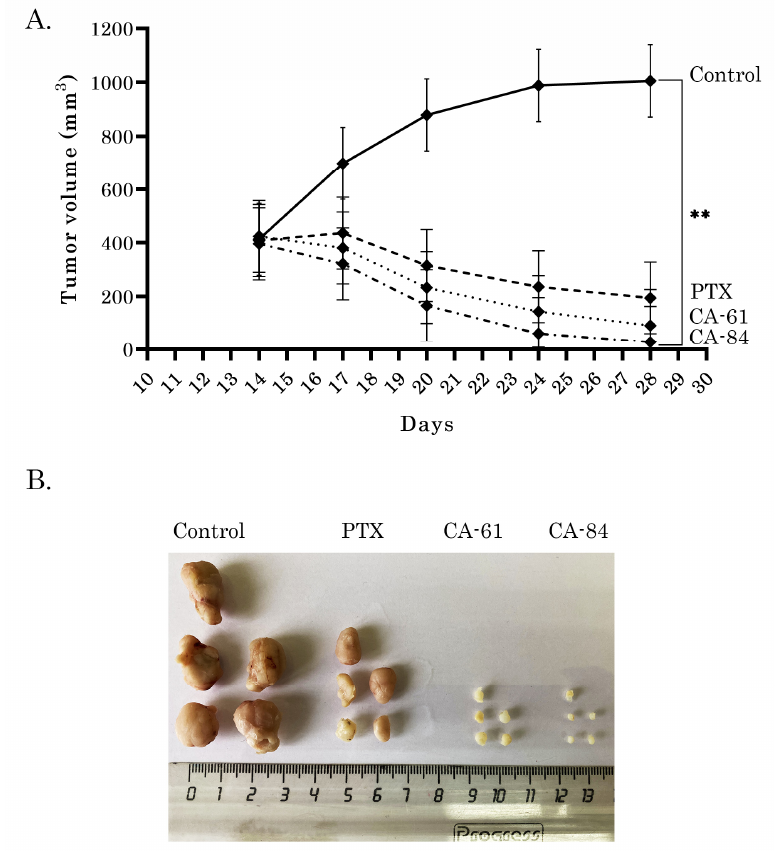
Figure 13. Antitumor effects of CAs and PTX in a nude mice xenograft tumor model. After HCC1806 breast cancer xenografts reached ~400 mm 3 of volume (day 14), nude mice were randomized into 4 groups (n = 5) and administered i.p. 150 µ L of vehicle (negative control), CA-61, CA-84 (2 mg/kg), or PTX (10 mg/kg). The animals were treated according to the schedule specified in Materials and Methods ( A ) The changes in the tumor sizes were calculated as a percentage of baseline. The tumor volume in each group was assessed by calipers and calculated as the length × width × width × 0.5. Results were expressed as the mean volume of tumors (mean ± SD, n = 4; **: p < 0.001, compared to control (vehicle-treated) animals. ( B ) Representative images of the final tumor volumes in each ex- perimental group.